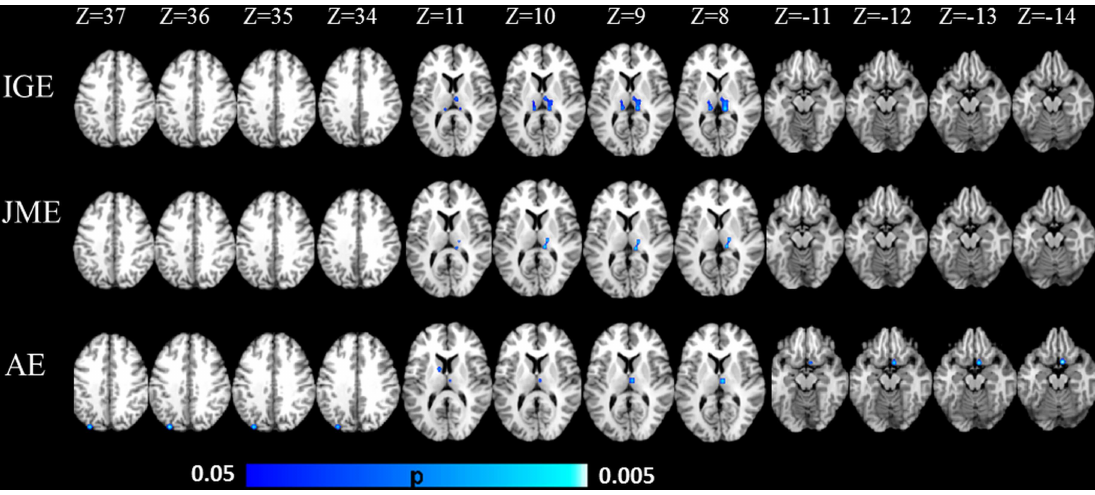
Fig 5. Results of ALE meta-analysis with GMV decrease. Significant GMV decreasewas found in: for IGE, bilateralpulvinar; for JME, right pulvinar;and for AE, right medialdorsal nucleus,right subcallosalgyrus, left caudate and left precuneus. IGE, idiopathicgeneralized epilepsy;JME, juvenilemyoclonicepilepsy; AE, absenceepilepsy;ALE, activationlikelihoodestimation; GMV, gray matter volume.